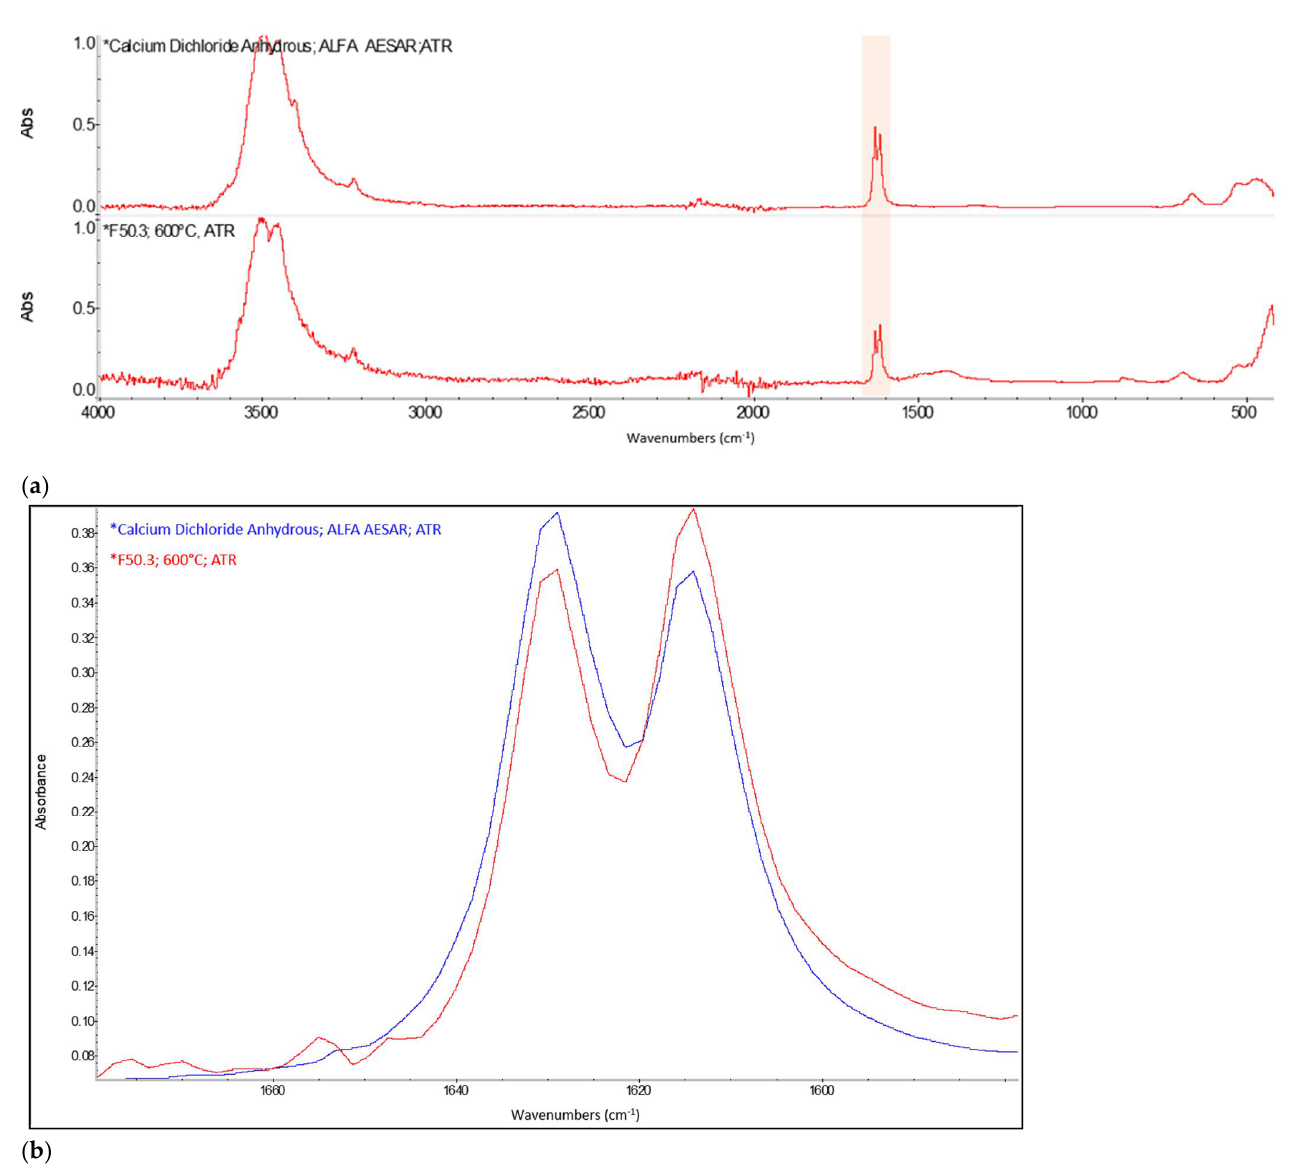
Figure A7. FTIR spectra: anhydrous CaCl 2 vs. ashes of F.50.3 at 600 °C: ( a ) scale 4000–400 cm −1 and ( b ) focus in the range 1660 cm −1 –1580 cm −1 , anhydrous CaCl 2 (blue) and ashes of F.50.3 (red). Anhydrous CaCl 2 shows two bands at 1628.43 cm −1 and 1614.21 cm −1 , and the sample spectrum matches them perfectly.